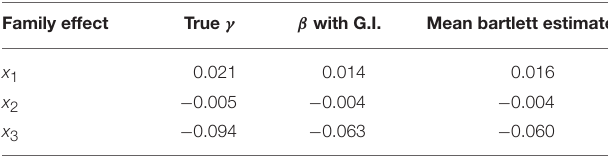
TABLE 5 | SRM as outcome, biased values of the regression coefficients of the family effect due to generalized inverse (G.I). Family effect True γ β with